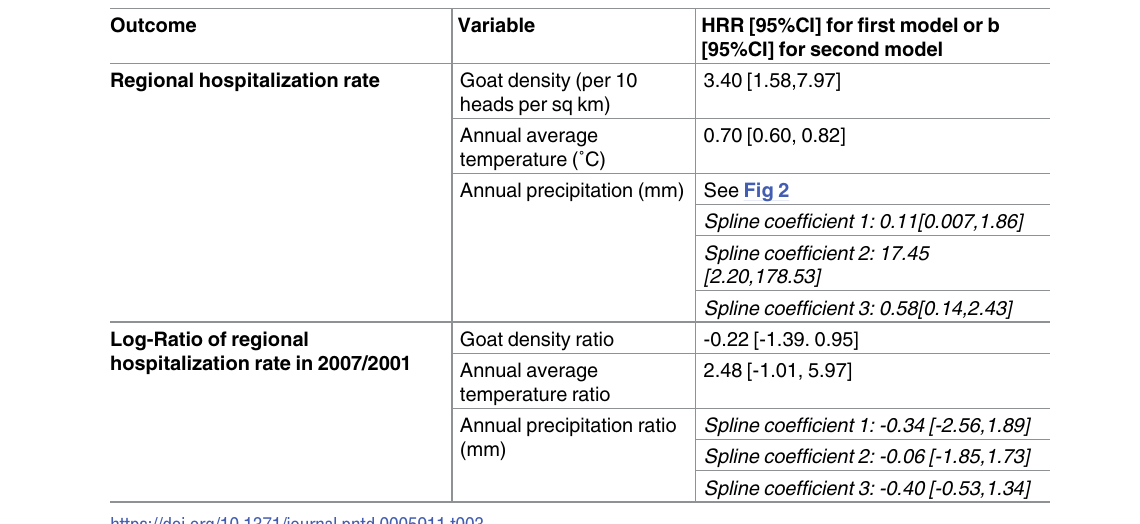
Table 3. Risk factors for cystic